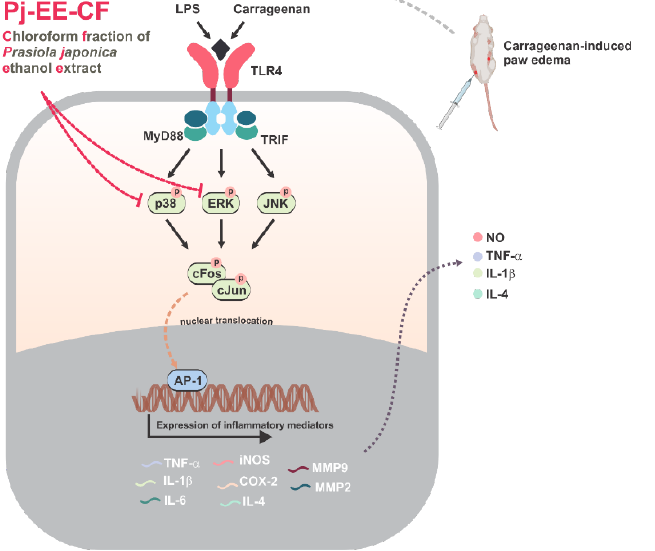
Figure 7. Schematic: anti-inflammatory mechanisms of Pj-EE-CF in the suppression of AP-1 signal- ing pathway.